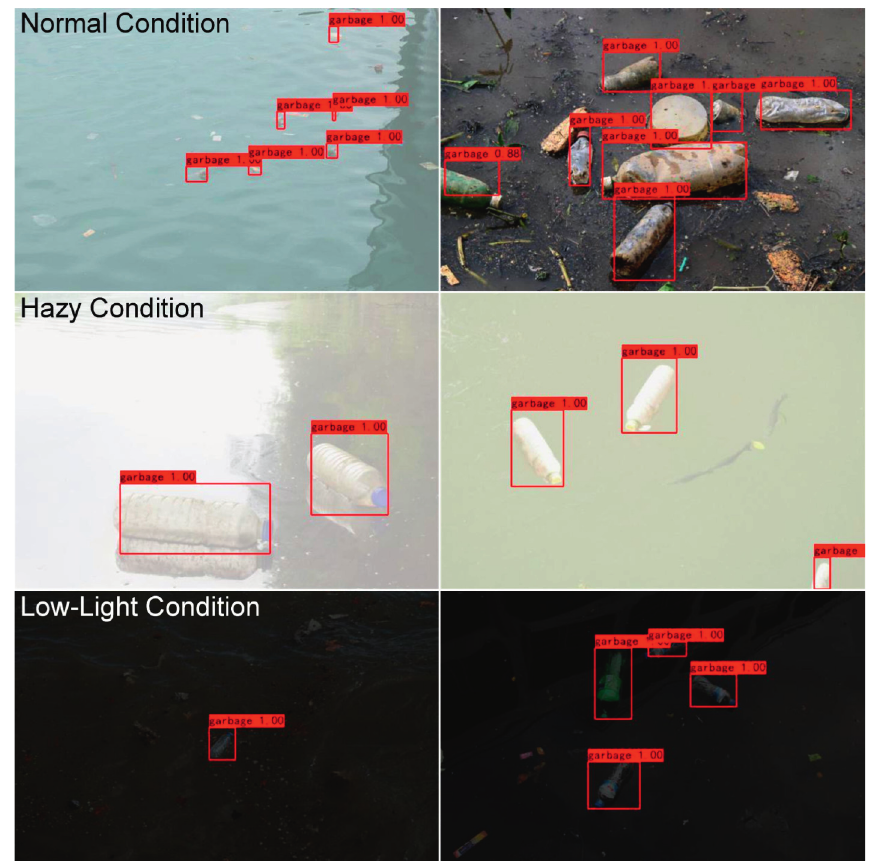
Figure 10: The robust detection results of our YOLOv4-based learning method in practical applications. From top to bottom: the water- surface garbage is detected from several different images obtained under normal, hazy, and low-light imaging conditions,